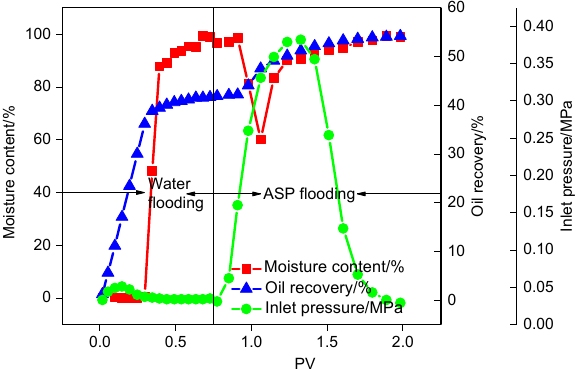
Figure 10. Curves of the injection and production of ASP flooding.